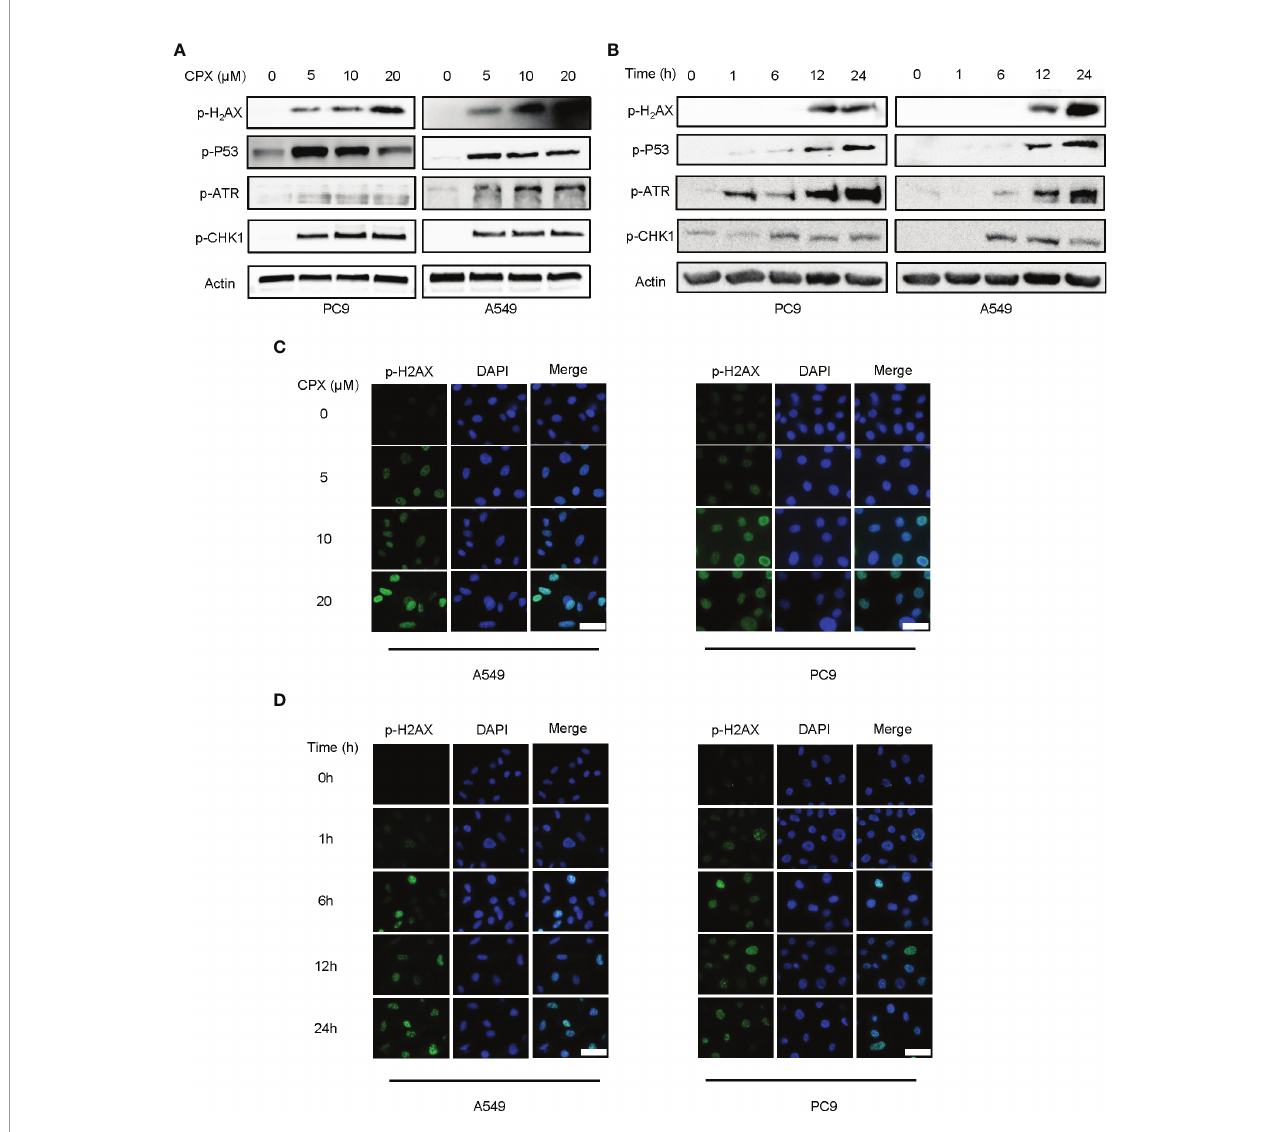
FIGURE 4 | CPX induces DNA damage and repair. (A) Western blotting showed p-H 2 AX p-ATR, p-CHK1, and p-P53 levels in LUAD cell lines pretreated with indicated CPX concentrations for 24 hours. (B) Western blotting showed p-H 2 AX, p-ATR, p-CHK1, and p-P53 levels at different time points after treatment with 5 m M CPX. (C) Immuno fl uorescence images showing p-H 2 AX staining in LUAD cells pretreated with indicated CPX concentrations for 24 hours. (D) Immuno fl uorescence images showing